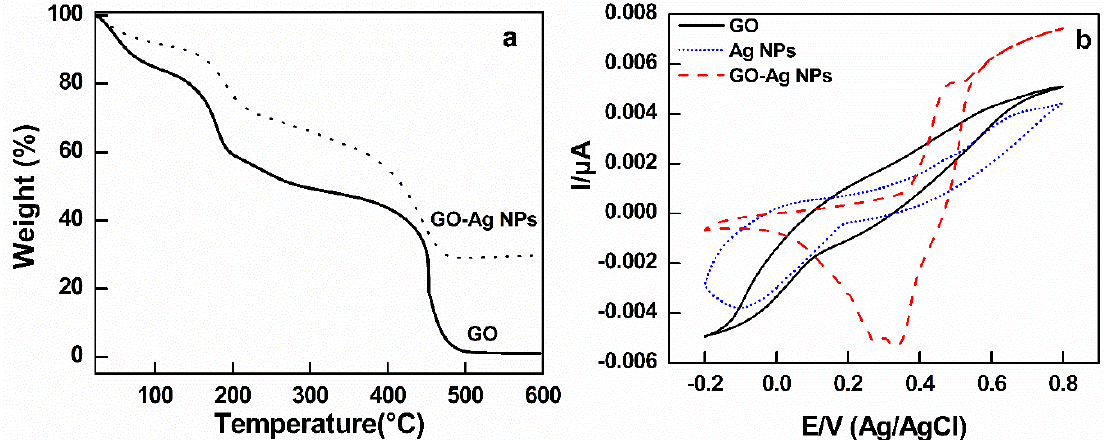
Figure 4. TGA analysis of GO and GO–Ag NPs in air atmosphere at the heating rate of 5 °C min −1 ( a ) and CV curves for GO, Ag NPs and GO–Ag NPs ( b ). The CV test was carried out in 0.01 M PBS and 1 mM H 2 O 2 electrolyte at the scan rate of 50 mV s −1 .